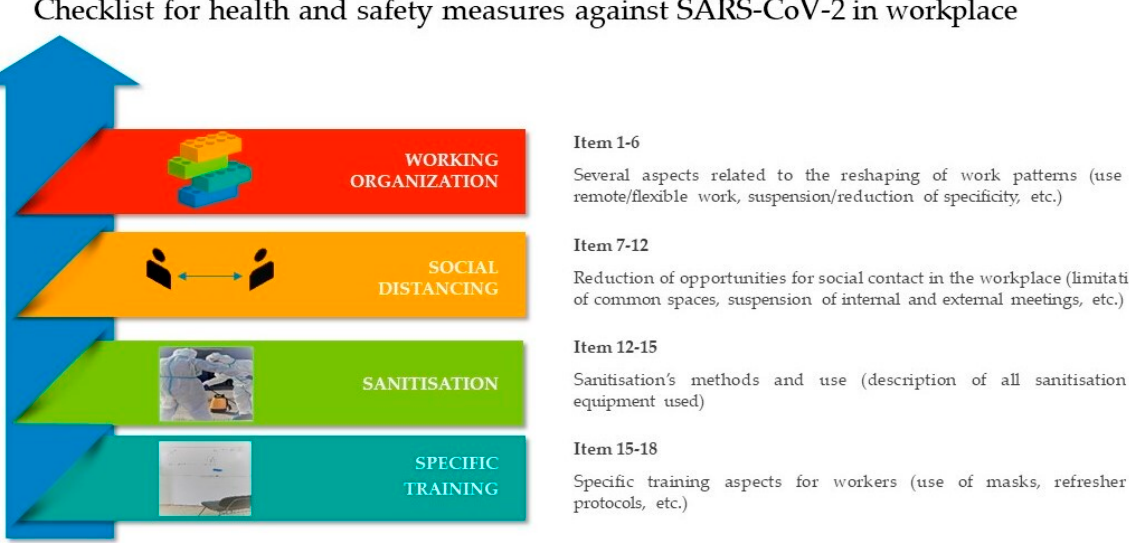
Figure 1. Representation of the four macro-items synthesis from the Italian Regulatory Shared